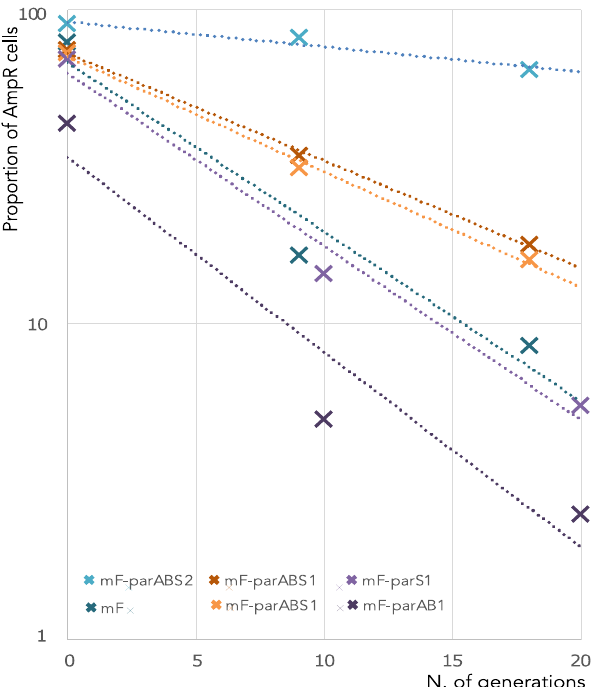
Figure 1. Stability of miniF plasmid derivatives in E. coli . The graph represents the proportion (in %) of Amp R cells (containing plasmid) at different time points during ≈ 20 generations of LB growth of an E. coli strain containing one of the different miniF derivatives indicated in the figure inset. Regressions of the data are shown by lines with the same color codes as data, and their slopes correspond to the proportion (%) of plasmid loss per generation.